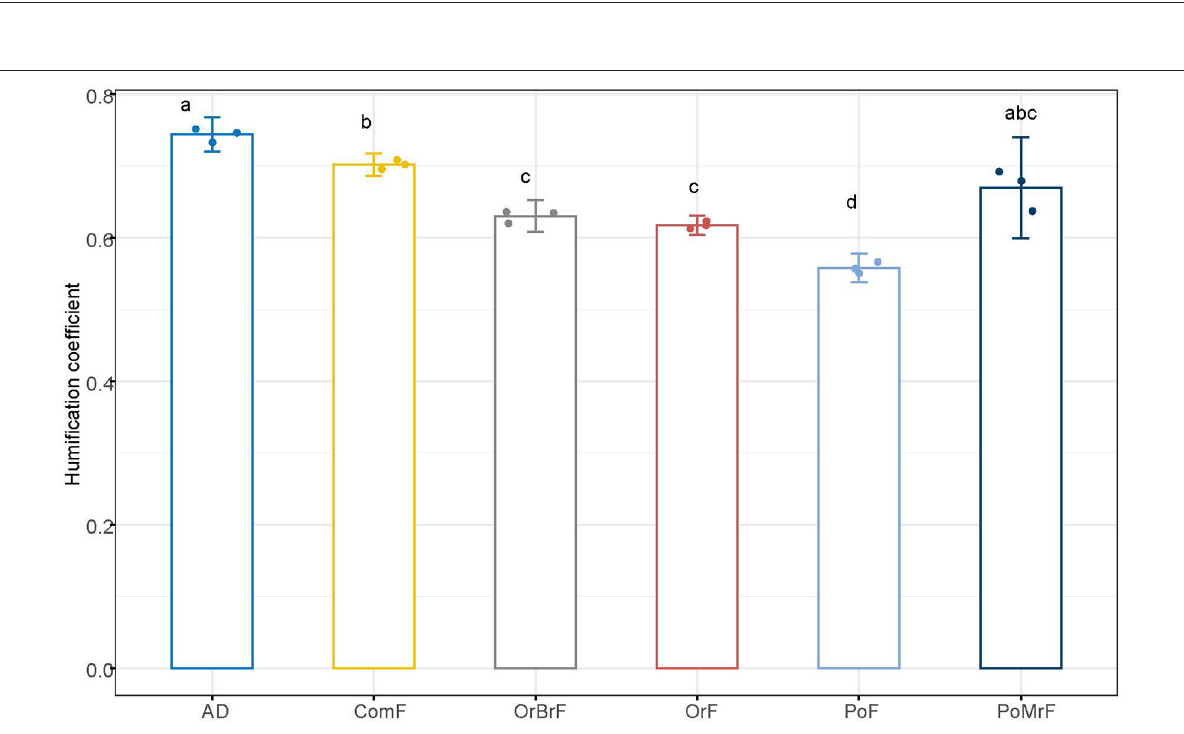
Frontiers in Sustainable Food Systems |